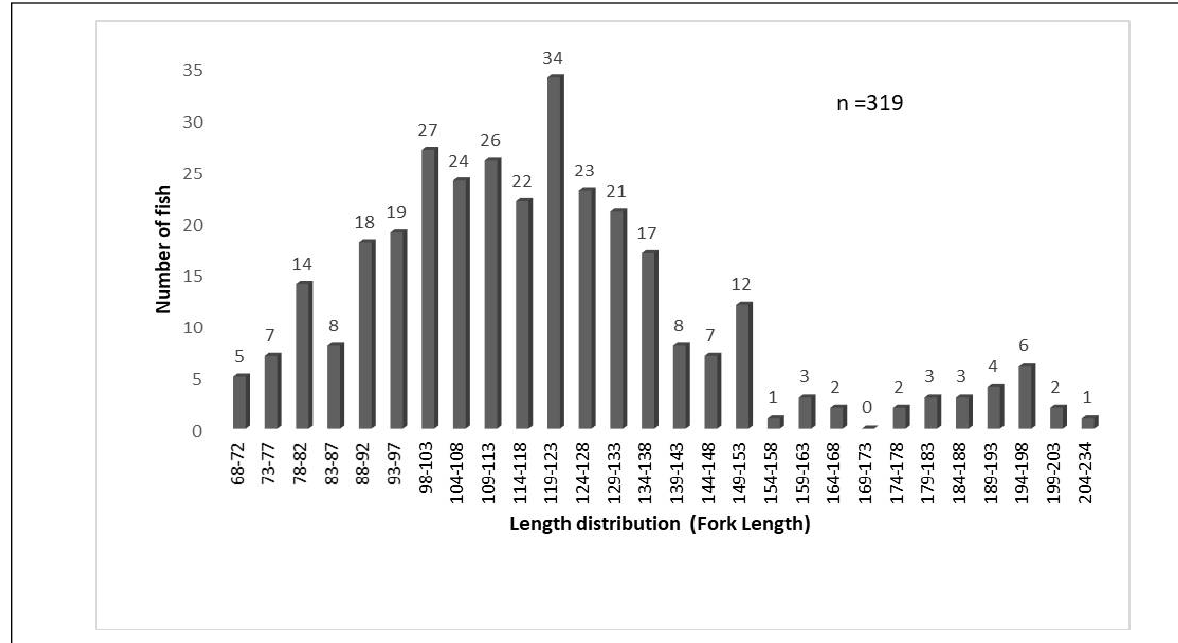
Figure 3: Length-frequency distribution for Xiphias gladius sampled in the coastal waters of Kenya